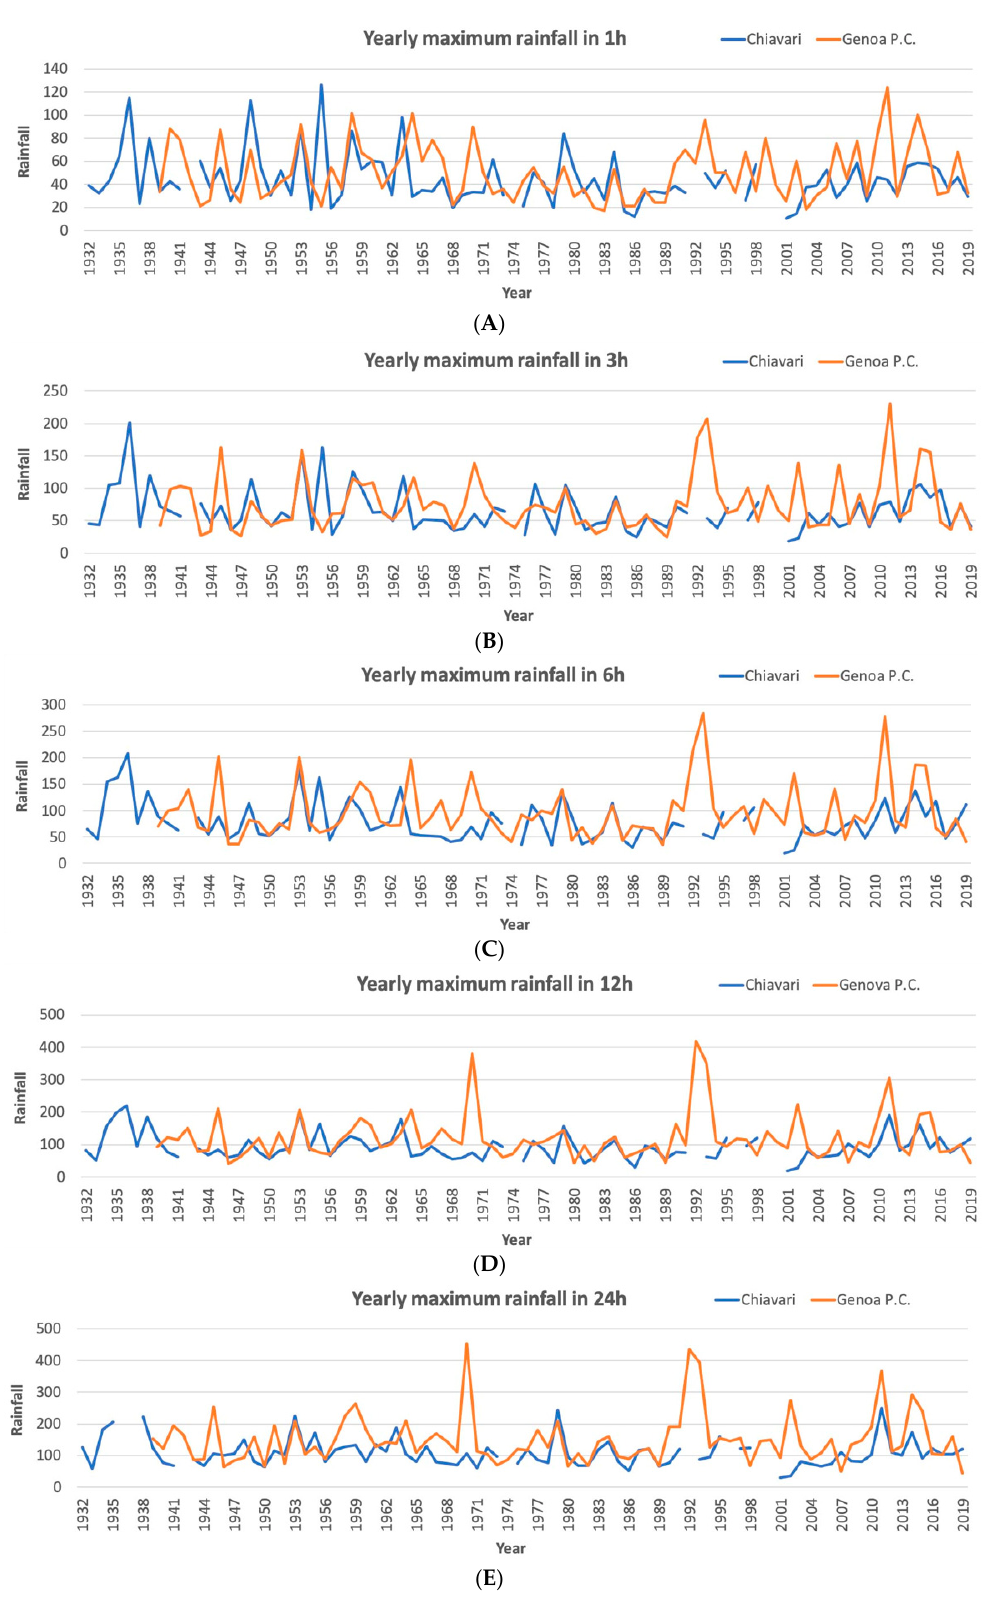
Figure 13. Maximum rainfall in 1 ( A ), 3 ( B ), 6 ( C ), 12 ( D ), and 24 ( E ) h in the yearly series of Chiavari (1932–2019) and Genova Ponte Carrega